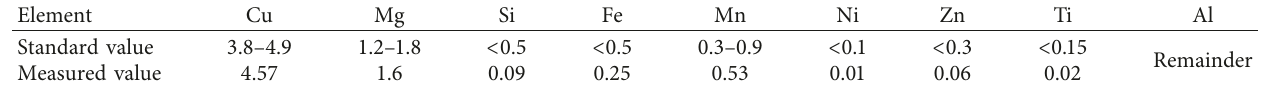
Table 2: Chemical components of 2A12-T4 aluminum alloy (%).